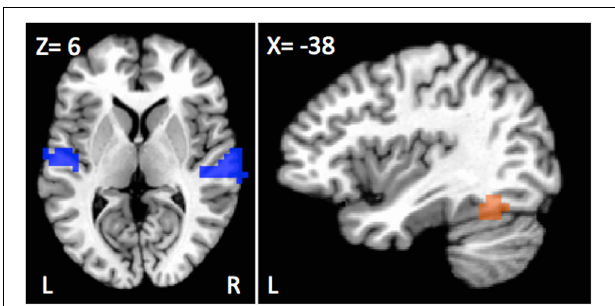
FIGURE 1 | Regions showing differences in activation as a function of population for the sentences vs. falsefont contrast. Bilateral superior temporal cortices, including the left primary auditory cortex (blue) showed greater recruitment for deaf individuals, signers or oral, than hearing participants. Left fusiform (orange) showed a different pattern with greater activation for hearing and oral deaf participants as compared to deaf native